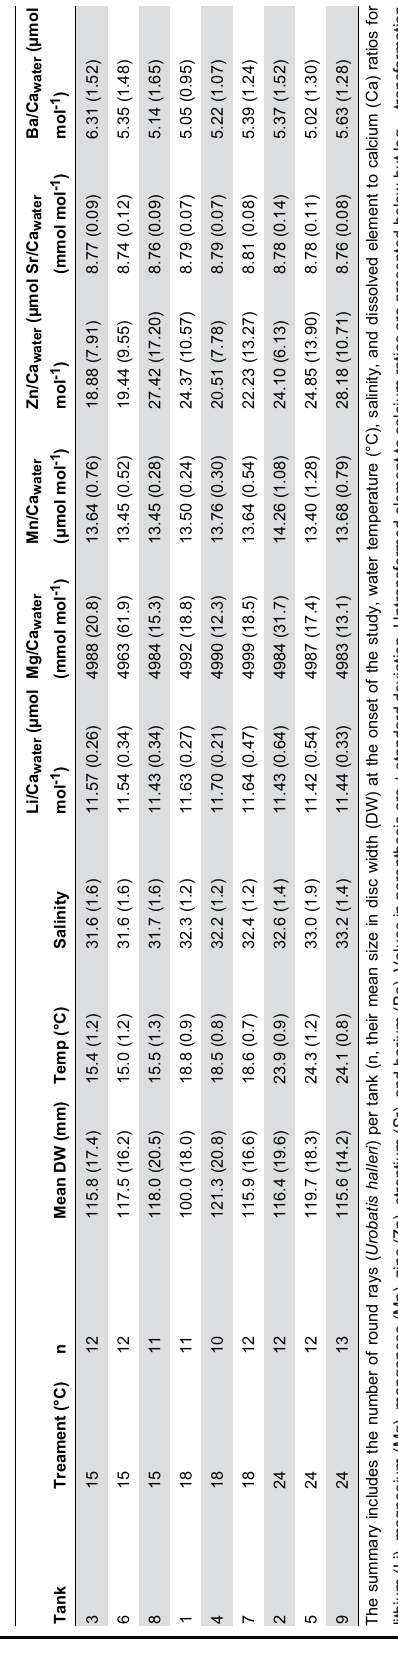
Significant differences were found across treatments (Figure 4; THSD, p < 0.001 for all pair-wise comparisons). Mean (± SD)